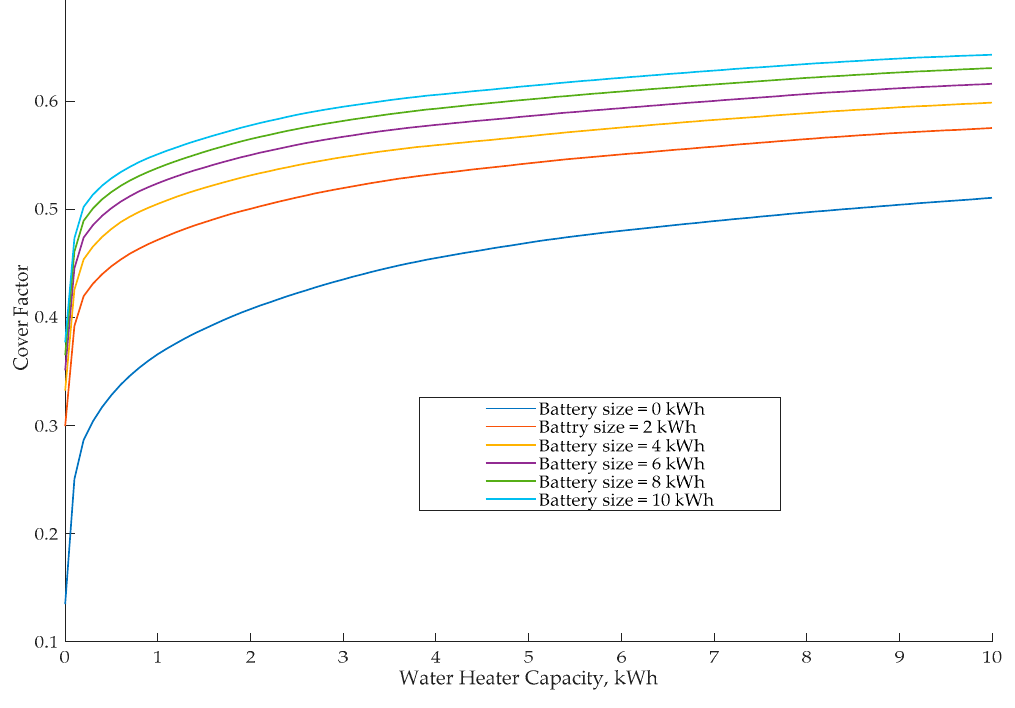
Figure 4. Cover factor Y D dependency on battery and water heater (WH) capacity.